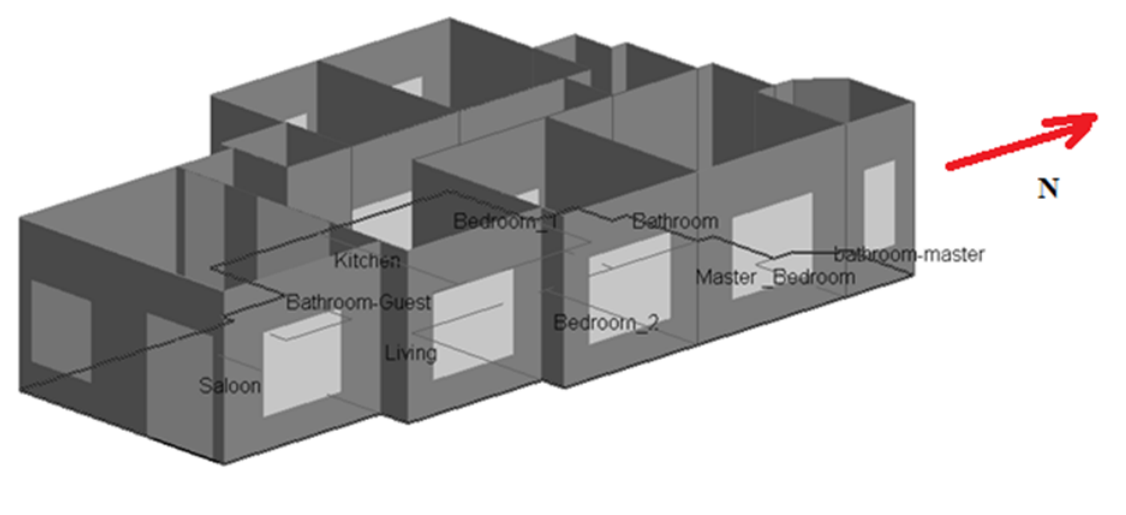
Figure 2. Overview of the building in DesignBuilder